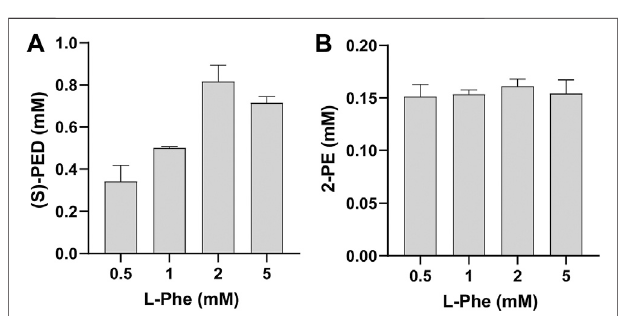
FIGURE4| EffectofL-Pheonthesynthesisof (A) ( S )-PEDand (B) 2-PE. Values show means with error bars representing standard deviations (s.d.) of at least three independent